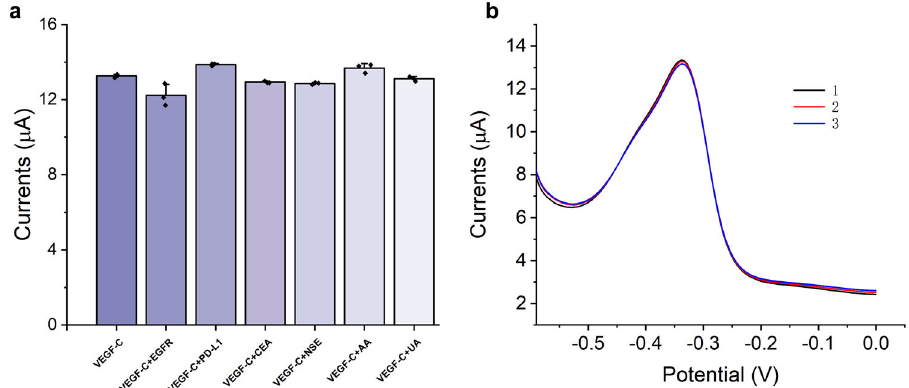
Fig. 4 Selectivity and repeatability performance of the immunosensor. a DPV responses of the paper-based immunosensor to 500 pg mL − 1 VEGF-C and 1 ng mL − 1 VEGF-C mixed with 10 ng mL − 1 interfering substances, including EGFR, PD-L1, CEA, NSE, AA, and UA, at a ratio of 1:1. b Repeatability of